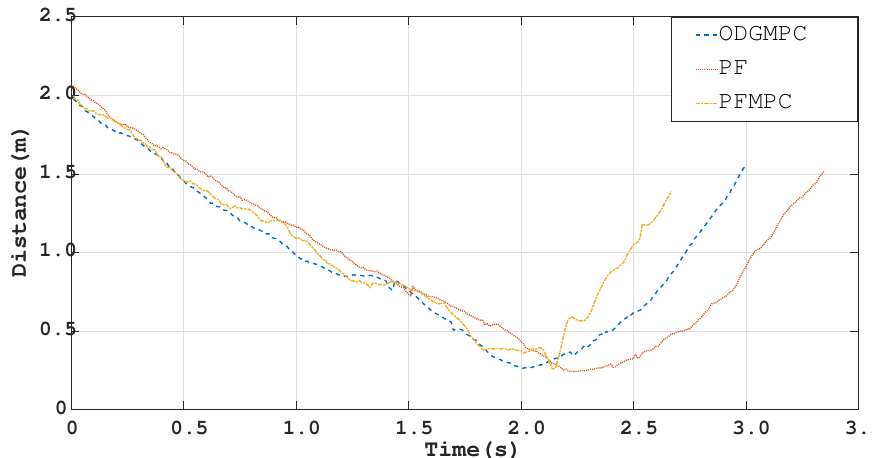
Figure 23. Results of the acceleration from Scenario 2 for a dynamic obstacle.